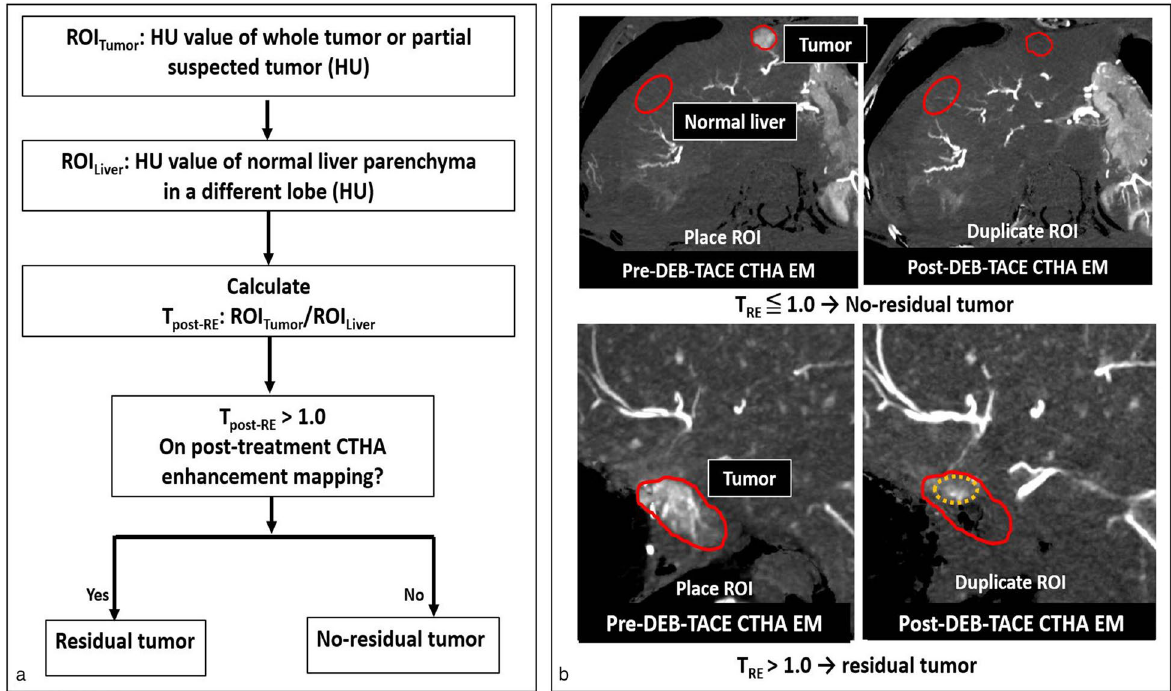
Fig. 3 Flowchart and two examples illustrating the proposed CTHA‑EM ROI‑based quantitative analysis. a Flowchart of quantitative assessment of residual tumor enhancement using CTHA‑EM. b Two cases exemplifying ROI‑based quantitative analysis. Top row: ROI Tumor (solid red circle) and ROI normal (dotted red circle) were placed on pre‑treatment CTHA‑EM images and transferred to the corresponding anatomical location on posttreatment CTHA‑EM images. Bottom row: For cases with suspected residual enhancement, voxels with higher attenuation (orange dotted circle) were used for T Post‑RE to avoid normalization bias from zero voxels due to subtraction of contrast stasis. T post‑RE , Relative enhancement of tumor on posttreatment images; CTHA-EM , Computed tomography hepatic arteriography enhancement mapping; ROI , Region of